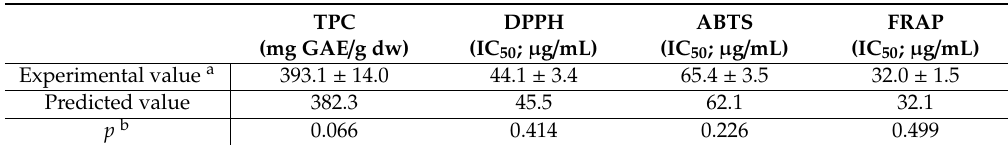
Table 3. TPC and antioxidant activity evaluated by TPC, DPPH, ABTS and FRAP assays of the optimal extract of C. sativa shells (70 ◦ C / 40